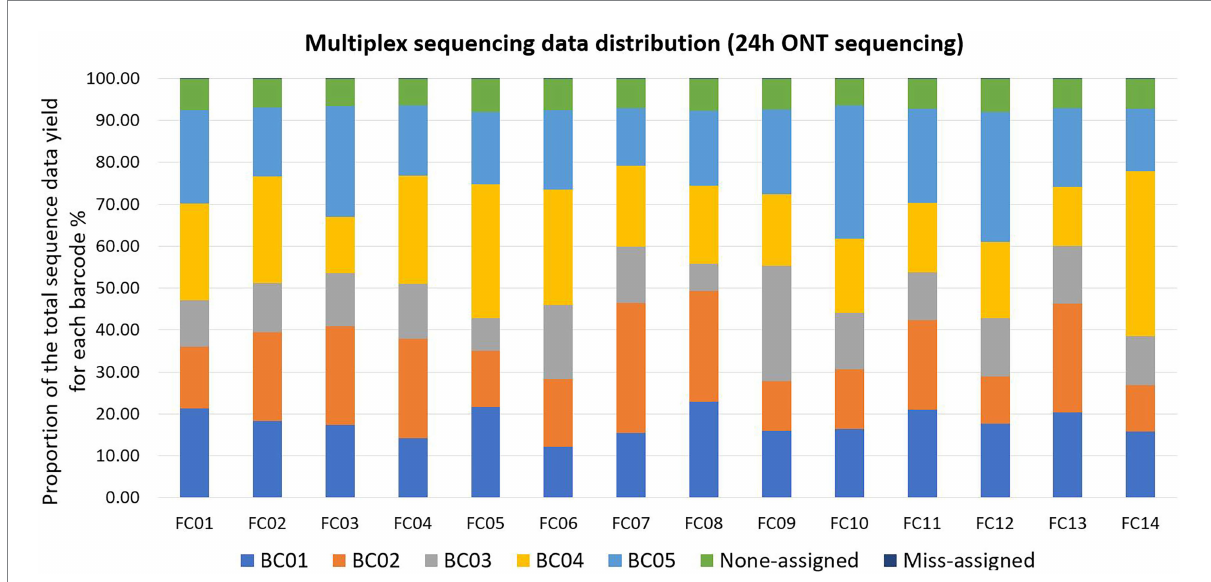
FIGURE 2 Multiplex sequencing data distribution within each flow cell (FC) for each barcode (BC) after 24 h of ONT sequencing. Each color represents one BC or none-assigned/miss-assigned reads. Within each FC, ONT reads that were not assigned to any BC were defined as non-assigned reads, reads assigned to a BC that was not used in the FC were defined as miss-assigned reads. As the bars for miss- assigned reads were not easily visible, detailed proportions are listed here: the number of mis-assigned reads was 2% in FC02 and FC05, and 3% in all the other